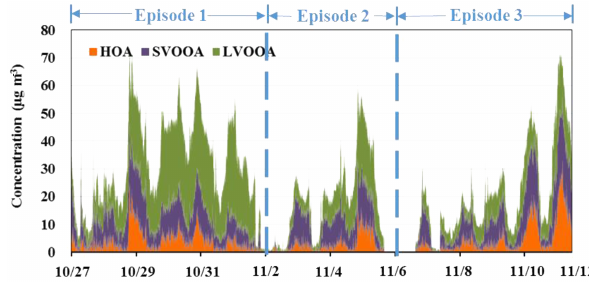
Figure 3. The temporal changes of organic components in PM 1 at the Liulihe